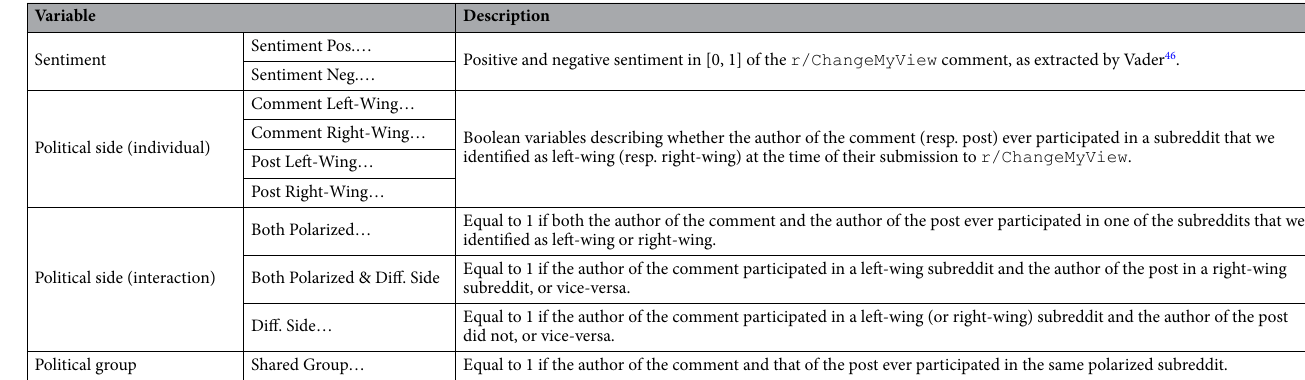
Table 3. Explaination of the confounders used in the logistic regression models (Table 2). More details are provided in “Confounders”